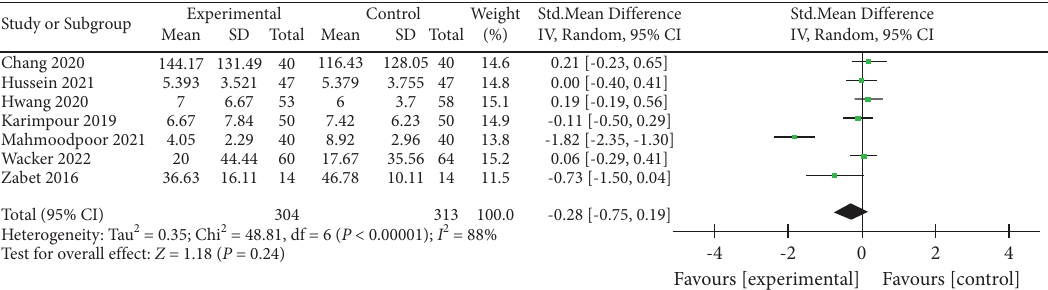
Figure 14: Forest plots for the efect of vitamin C on the duration of mechanical ventilation.